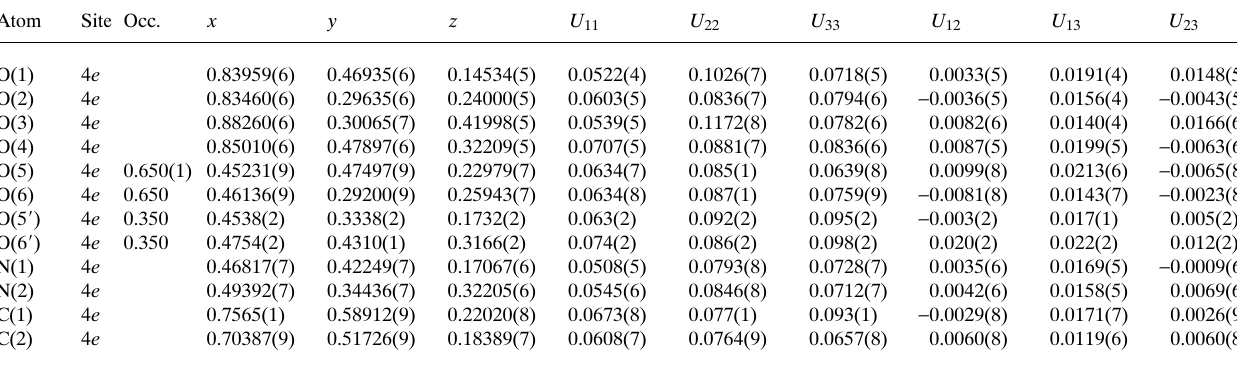
Table 3. Atomic coordinates and displacement parameters (in Å 2 ) .